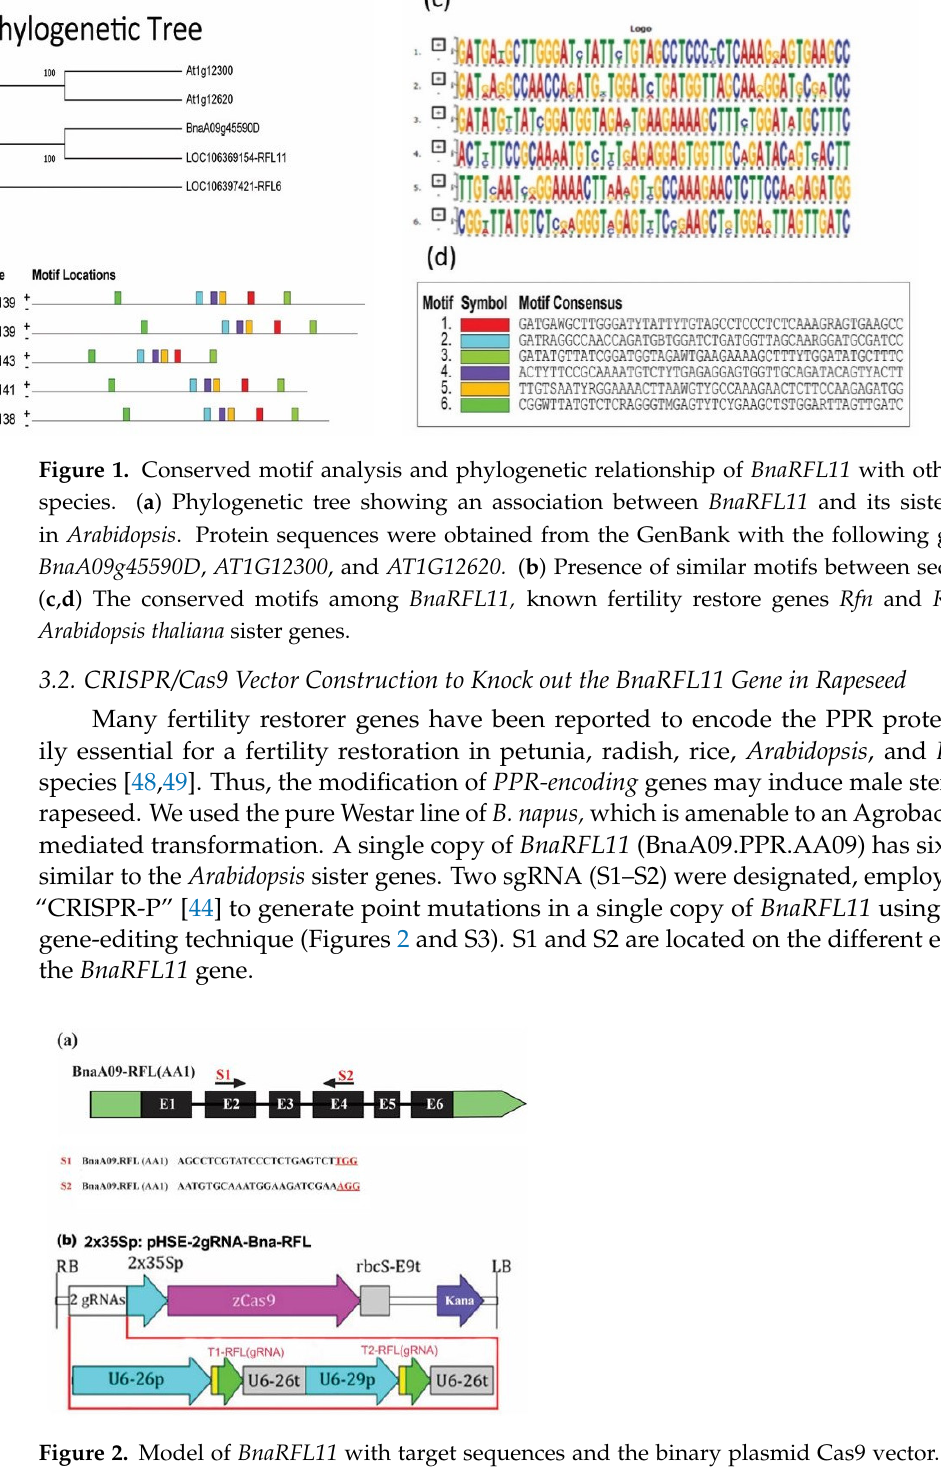
Figure 2. Model of BnaRFL11 with target sequences and the binary plasmid Cas9 vector. ( a ) The BnaRFL11 gene structure is shown in black. The vertical line indicates the gene model, and the arrow shows the sgRNA direction. The target sequences of sgRNAs are represented by PAM sites highlighted in red. ( b ) The kanamycin resistance cassette is driven by the CaMV35S promoter of the cauliflower mosaic virus. Two sgRNAs are driven by the U6-26p and U6-29p promoters and the U6-26t terminator.